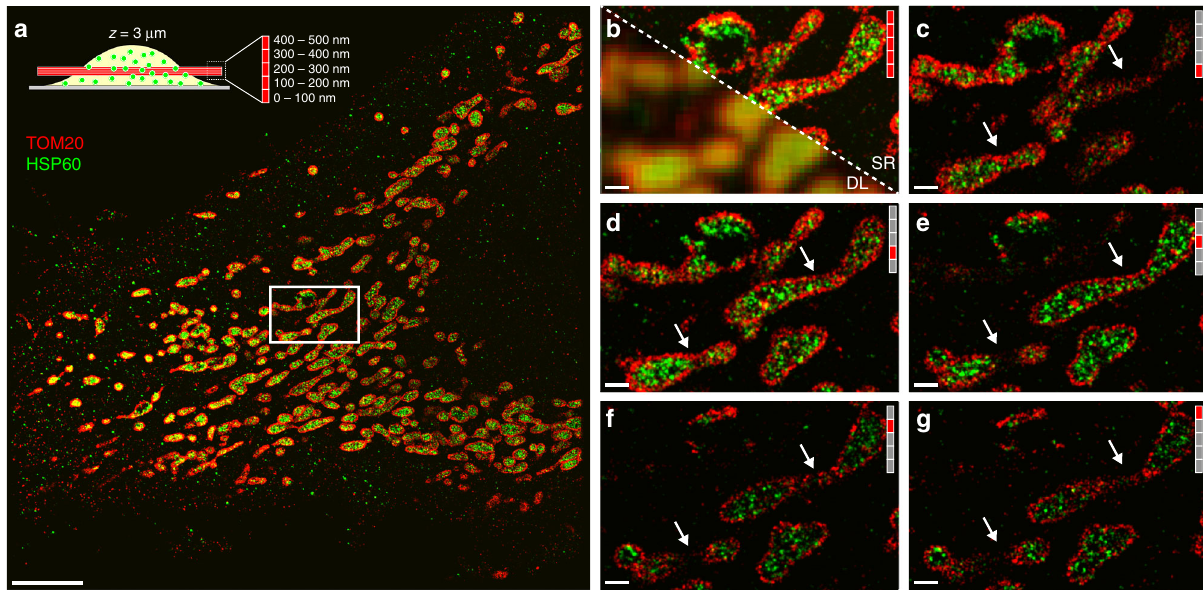
Fig. 3 Multiplexed 3D-Exchange-PAINT optical section inside a cell. a 2D projection of a 500-nm thick SDC slice ~3 µ m inside a fi xed HeLa cell. Two-target Exchange-PAINT targeting TOM20 (red) and HSP60 (green). Top left: Schematic drawing of the cell along with the detection volume (red). The 500-nm thick detection volume is split up into smaller slices (100 nm thick, see zoom-in) using astigmatism-based 3D super-localization. b Comparison of diffraction-limited (DL) and DNA-PAINT image (SR) of the highlighted area in a . c 3D super-resolved z -slice (0 – 100 nm, see height indicator on the top right) of the highlighted area in a . The arrows highlight areas that change appearance throughout the whole 500 nm slice. d 3D super-resolved z -slice (100 – 200 nm) of the highlighted area in a . e 3D super-resolved z -slice (200 – 300 nm) of the highlighted area in a . f 3D super-resolved z -slice (300 – 400 nm) of the highlighted area in a . g 3D super-resolved z -slice (400 – 500 nm) of the highlighted area in a . Scale bars, 5 µ m ( a ), 500 nm ( b – g